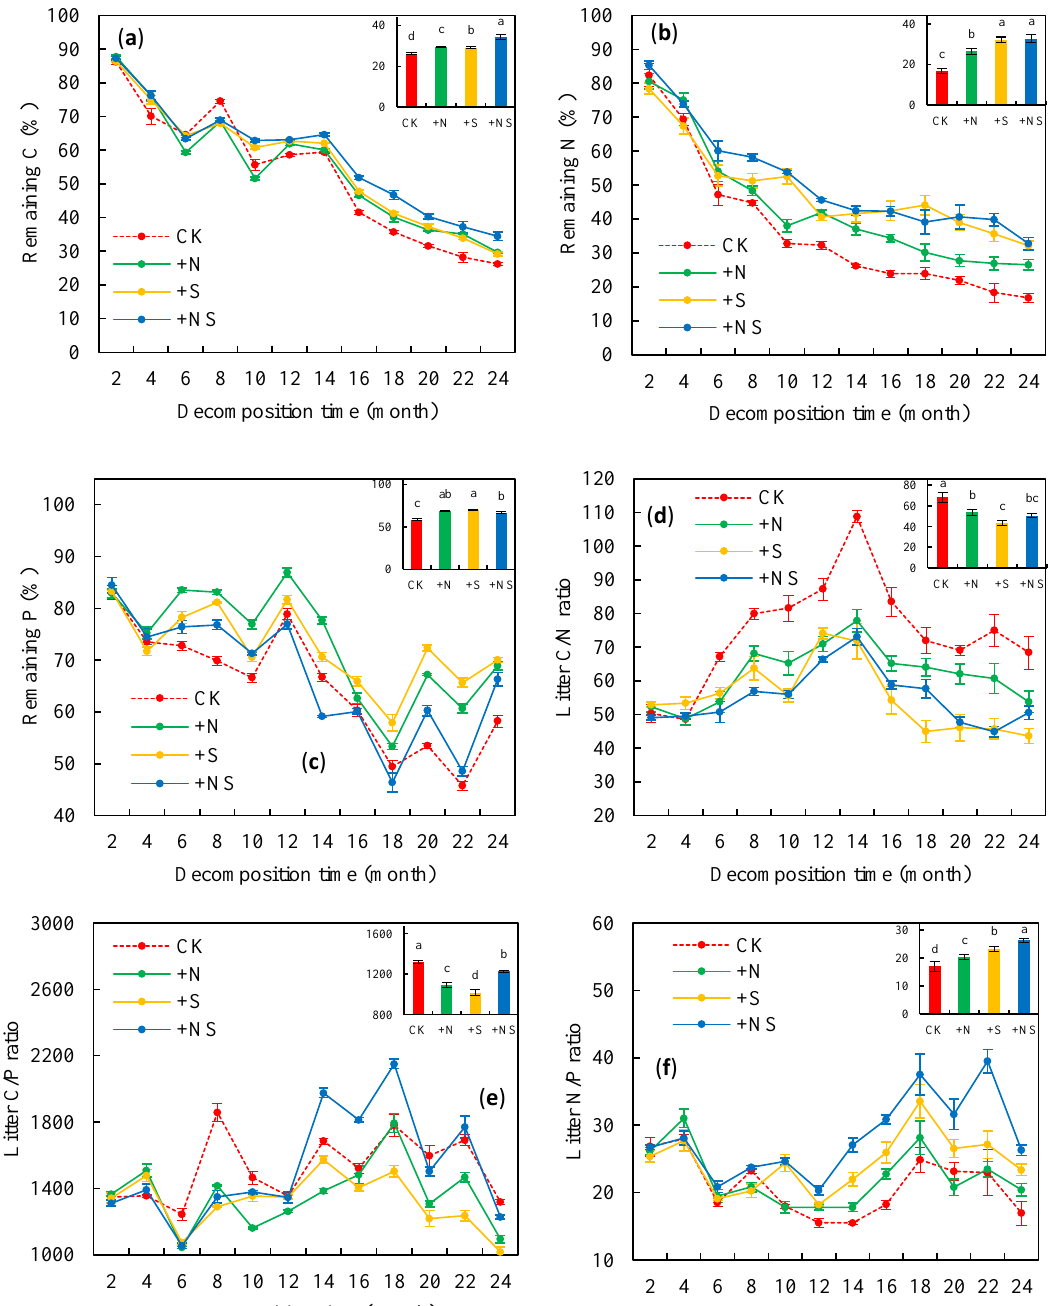
Figure 4. Remaining litter (% of the initial amount) C ( a ), N ( b ), and P ( c ) and C/N ( d ), C/P ( e ), and N/P ( f ) ratios during the decomposition process. The litter stoichiometry ratios are based on mass. Different lowercase letters in the histogram denote significant differences between distinct treatments at the end of this experiment based on one-way ANOVA ( p < 0.05). Values are the averages of three plot replicates ± standard deviations. The abbreviations for the treatments are defined in Figure 2.